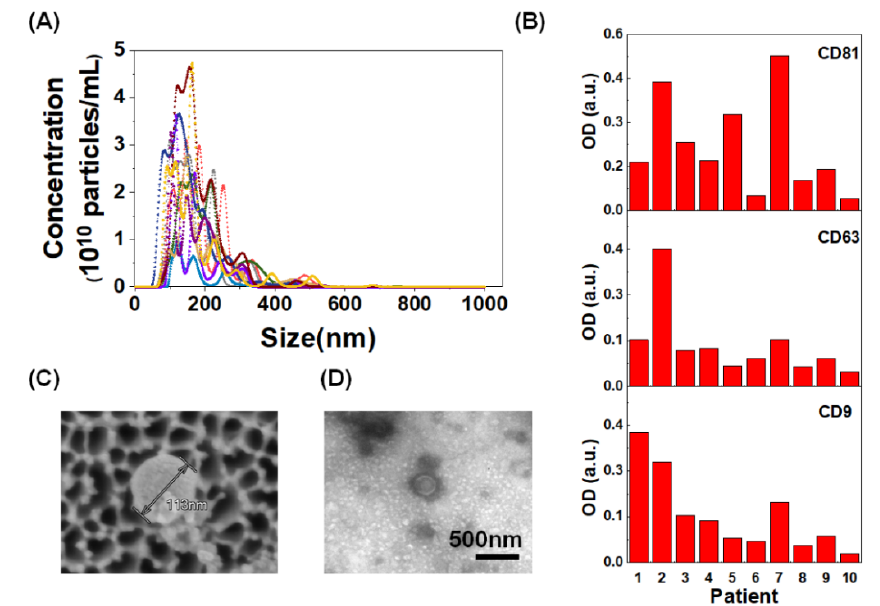
Figure 2. Characterization of extracellular vesicles (EVs): ( A ) size distribution and concentration of EVs measured by Nanoparticle Tracking Analysis; ( B ) EVs were confirmed by ELISA using CD9, CD63, and CD81 markers; and ( C ) scanning electron microscope and ( D ) transmission electron microscope images of bronchial